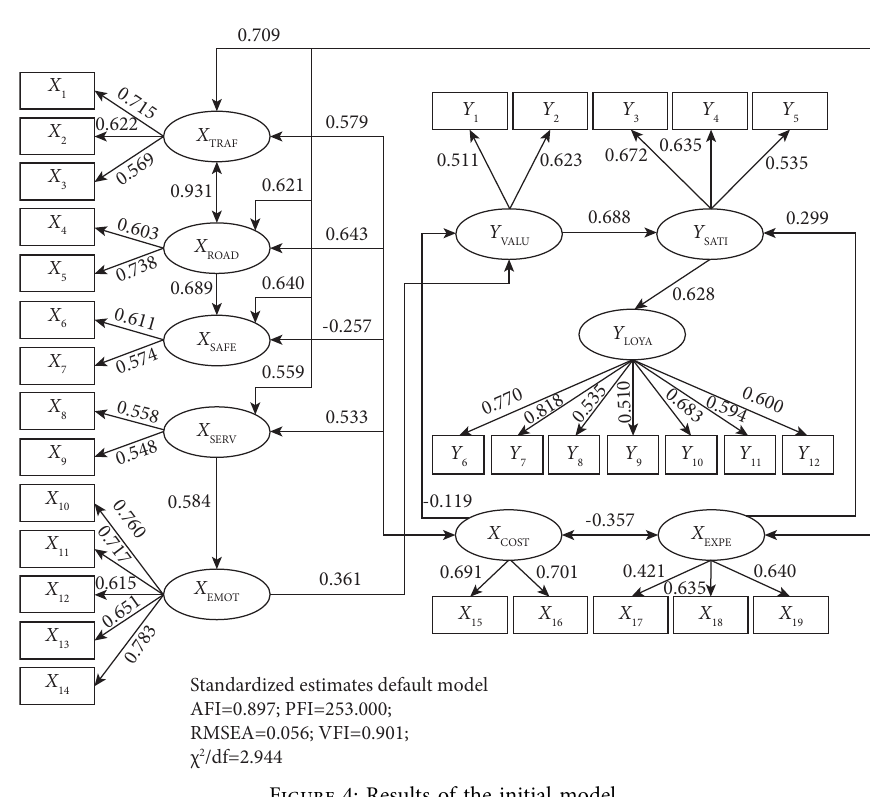
Figure 4: Results of the initial